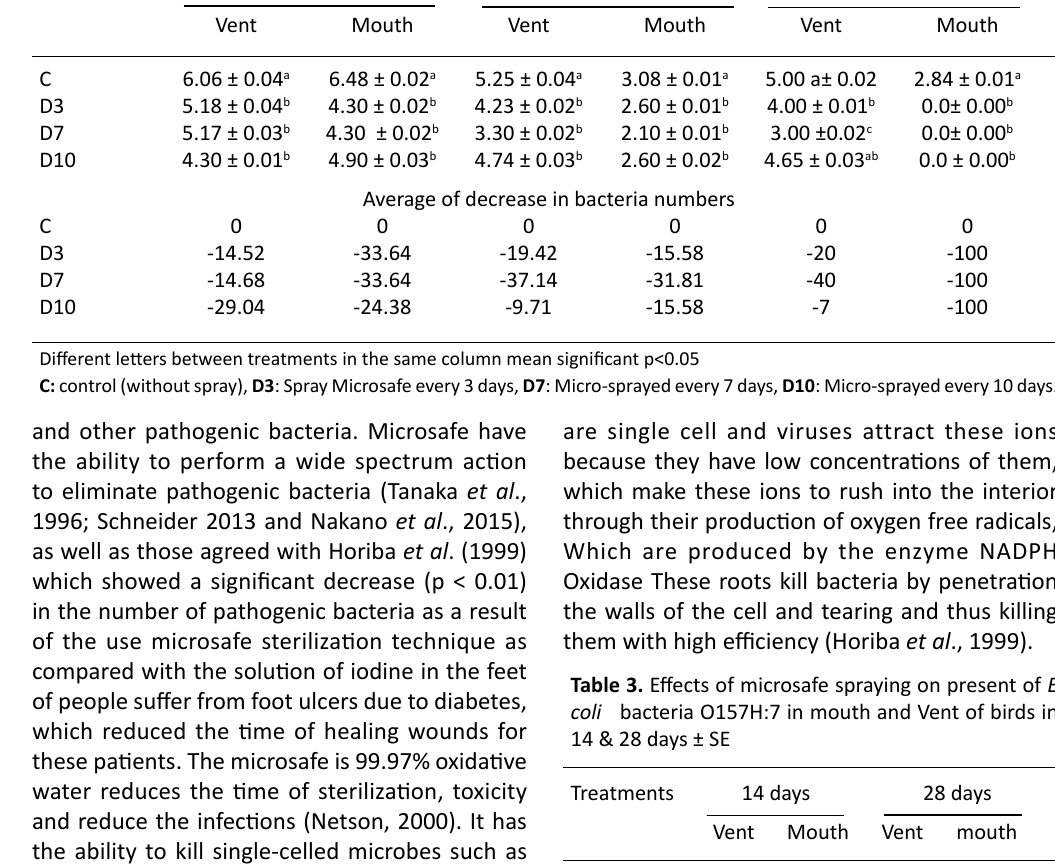
Table 2. Effects of micro save spraying on average on bacteria counts in mouth and Vent of birds in 28 days ± SE (CFU/g)